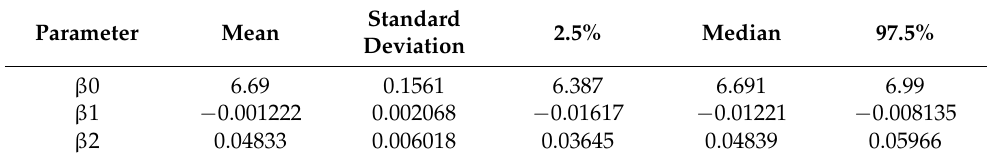
Table 3. MCMC parameter estimation